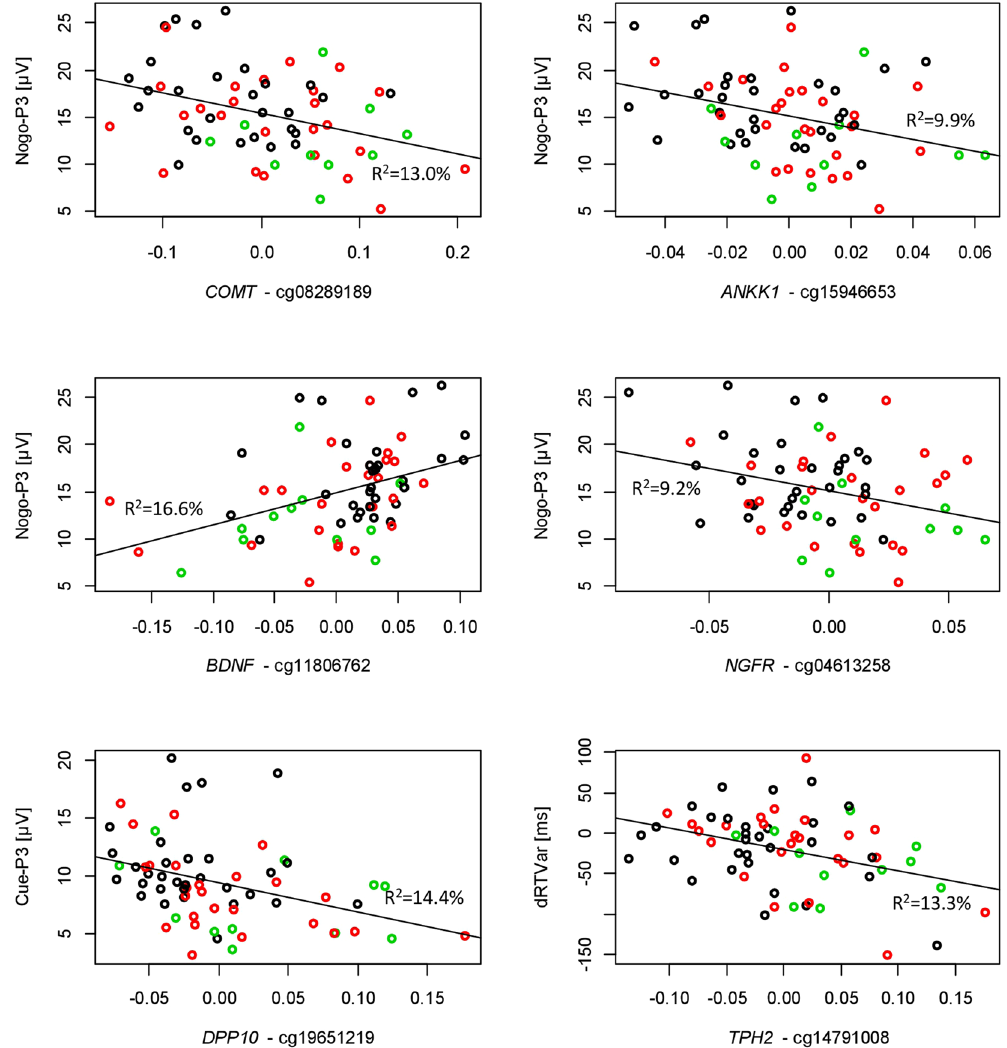
Figure 2. Scatter plots (with regression lines) showing associations between DNA methylation and functional measures (boys with FBB-ADHS total scores ≤ 0.5, controls: black circles; boys with FBB-ADHS total scores > 0.5 and ≤ 1, ADHD-low: red circles; boys with FBB-ADHS total scores > 1, ADHD-high: green circles). 5 of the 6 CpGs were hypermethylated in the groups with higher ADHD scores. It has to be noted that residuals are depicted which are centered at 0. dRTVar = difference of reaction time variability between blocks with and without motivational